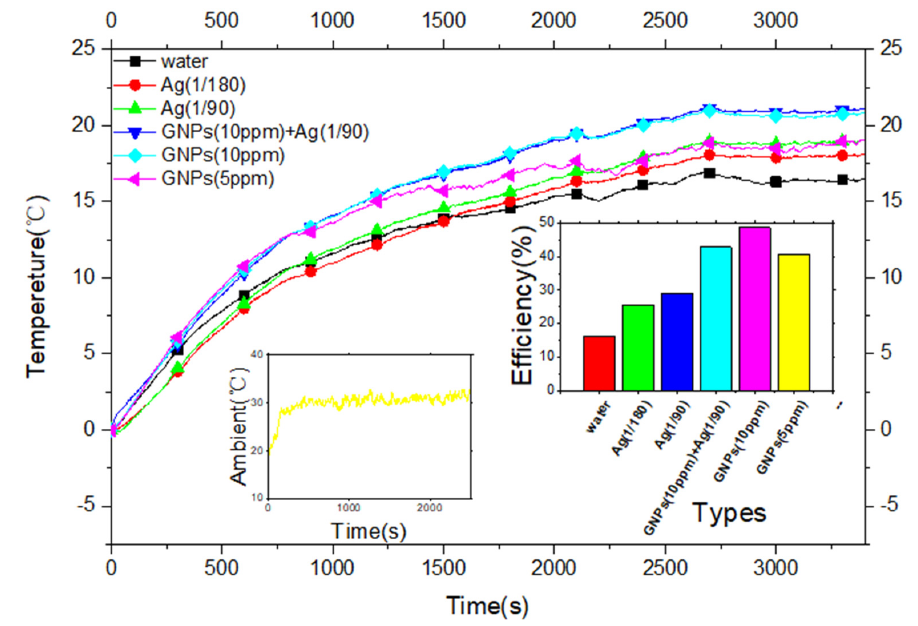
Figure 18. Predicted solar energy absorption efficiency and experimental results of Au − Ag hybrid nanofluid.